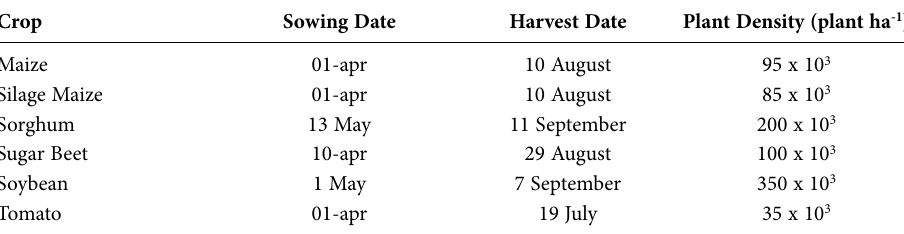
Table 1. Crop growing characteristics adopted in the simulation process.